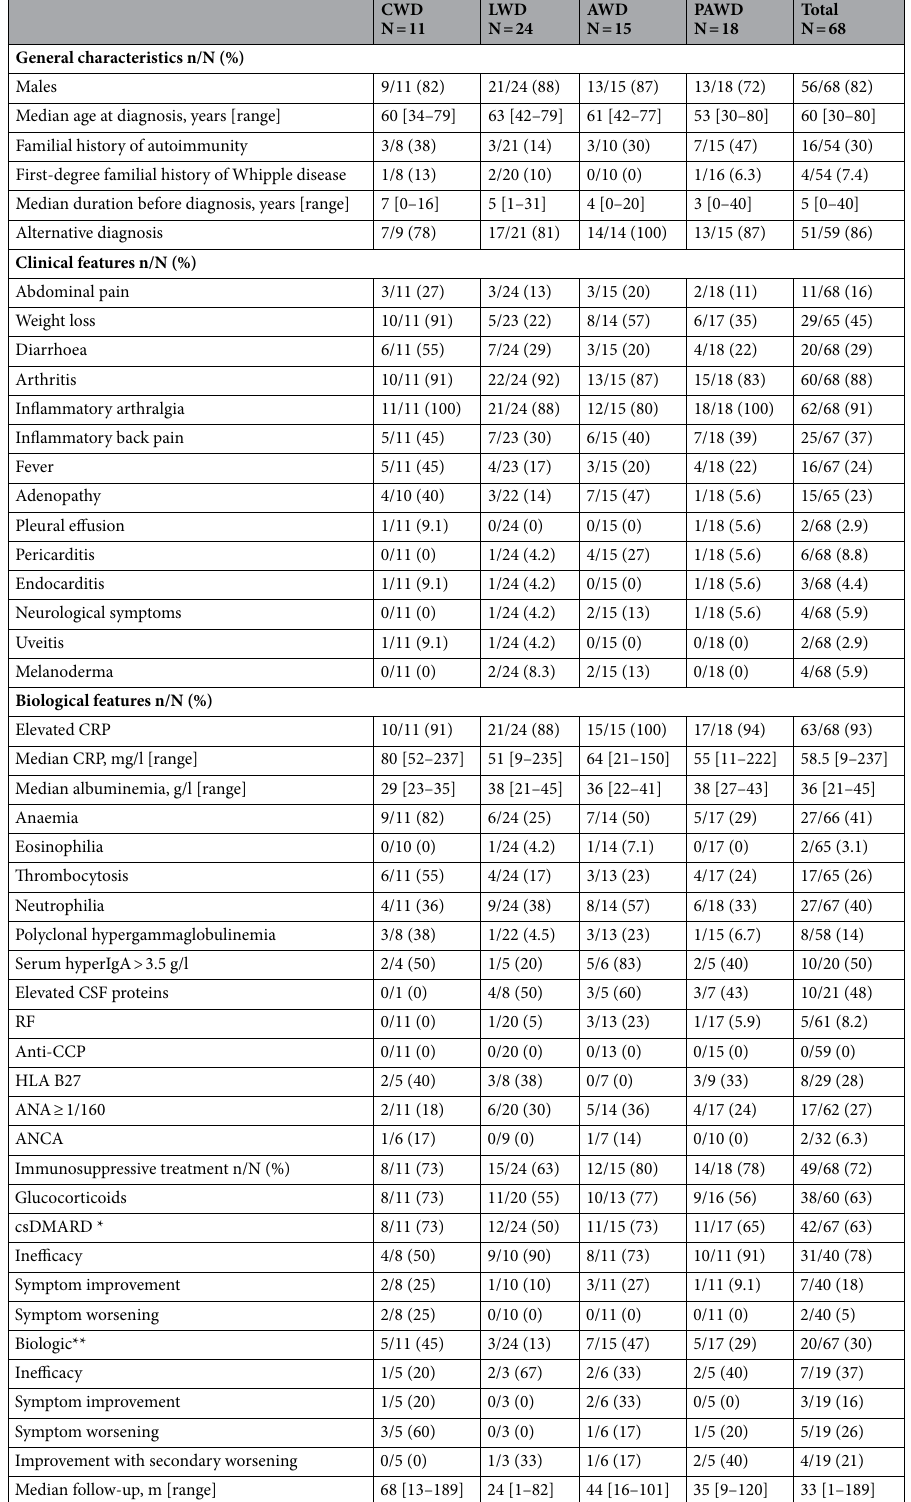
Table 1. Population general characteristics and clinical and laboratory features according to Whipple disease entity. ANA antinuclear antibodies; AWD arthropathic Whipple disease; CSF cerebrospinal fluid; CWD classic Whipple disease; csDMARD conventional synthetic disease-modifying anti-rheumatic drug; LWD localized Whipple disease; PAWD probably arthropathic Whipple disease; RF rheumatoid factor. *Methotrexate, salazopyrin, leflunomide, hydroxychloroquine, gold, azathioprine. **TNF inhibitor, abatacept, IL 12/23 inhibitor, IL 17 inhibitor, rituximab, IL1